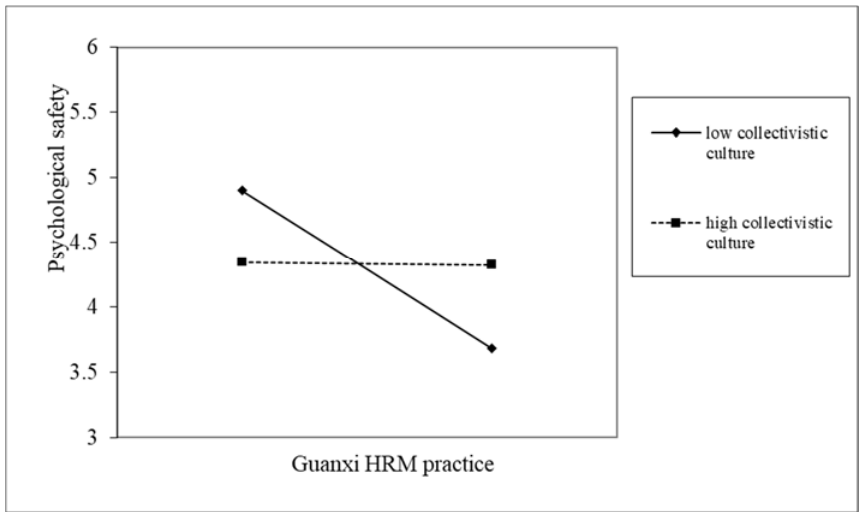
Figure 2. Interactive effects of guanxi HRM practice and collectivistic culture on psychological safety.